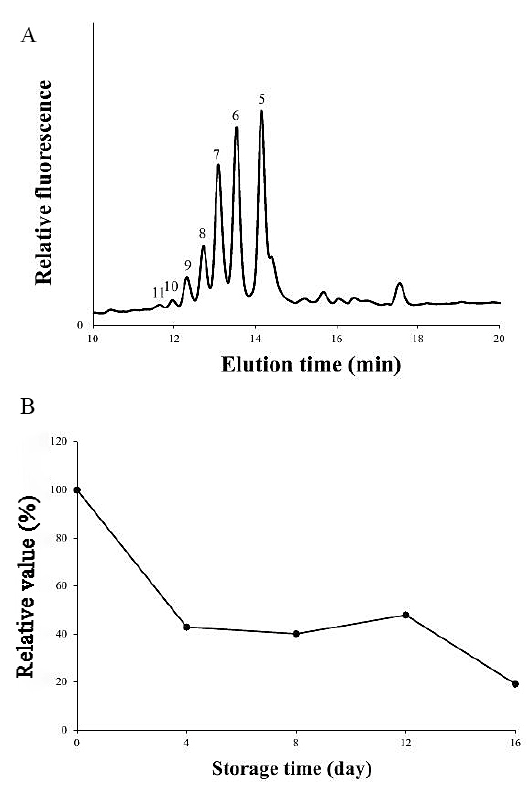
Figure 3. Xylan xylosyltransferase (XylT) activity ( A ) on day 0 measured using fluorescently tagged anthranilic acid (AA) Xyl 5 –AA as exogenous acceptors, and relative value, ( B ) compared to xylan XylT activity on day 0 of MBSes during the 4 ◦ C storage period. The reaction was conducted by mixing MBS microsomes with cold UDP–Xyl and the fluorescent acceptors Xyl 5 –AA and incubated at room temperature (RT) for 6 h, and the reaction products were separated by reversed-phase high-performance liquid chromatography (RP)-HPLC and detected by a fluorescence detector. Microsomes from the middle of MBSes stored at 4 ◦ C for 0–16 days were isolated, and the XylT activities were measured as described in “Materials and Methods”. The activity on 0 day is a reference. Data represent the mean of double measurements.